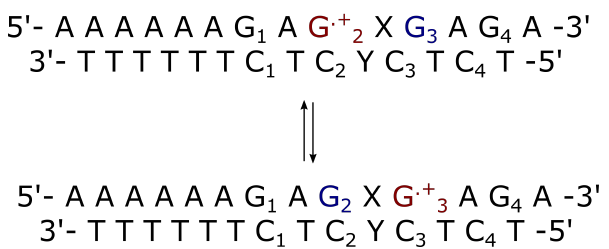
Figure 3. Schematic representation of intrastrand charge transfer in double strands where the bridge is X = { A,AA,AAA,T,TT,TTT } and Y is the complementary strand of X. The electron donor is G 3 (in blue) and the acceptor is G . + (in red). These two Guanine bases belong to the same strand. 2